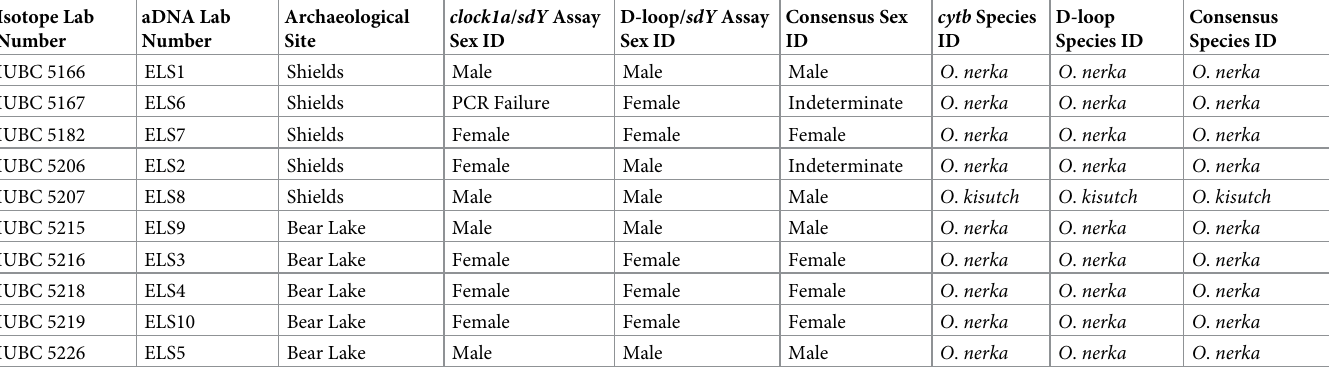
Table 1. Genetic species and sex identification results for the archaeological samples included in the ancient DNA analysis. Isotope Lab aDNA Lab Archaeological Number Number